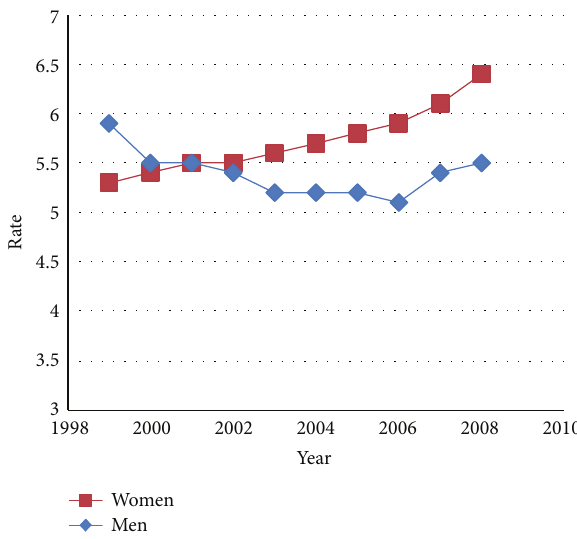
Figure 1: Age-standardized death rate per 100,000 population for decedents with pulmonary hypertension listed as any contributing cause of death by sex and year—United States 1999–2008. Age is standardized using the 2000 U.S. standard population.